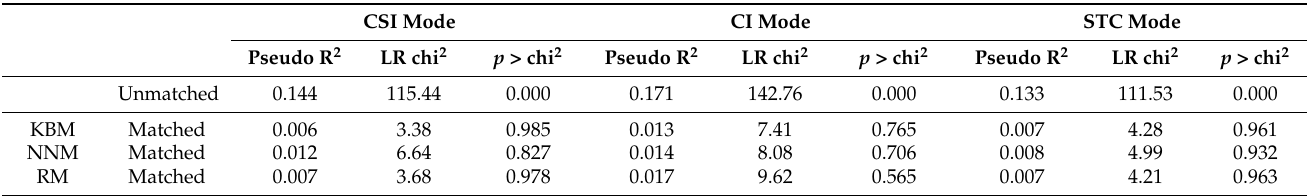
Table A2. Joint test of whole covariates before and after